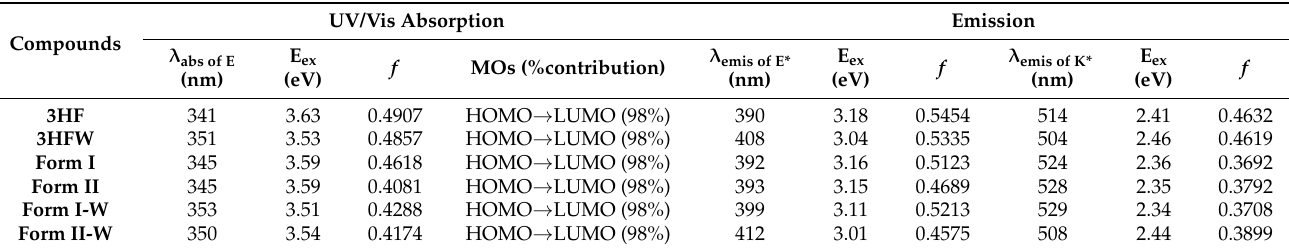
Table 3. UV/Vis absorption band maxima of enol form ( λ abs of E ), emission band maxima of enol ( λ emis of E ) and emission band maxima of keto forms ( λ emis of K ), the excitation energy (E ex ), and the oscillator strength ( f ) as well as their major contribution (%) calculated by TD-PBE0/def2-SVP level of theory.